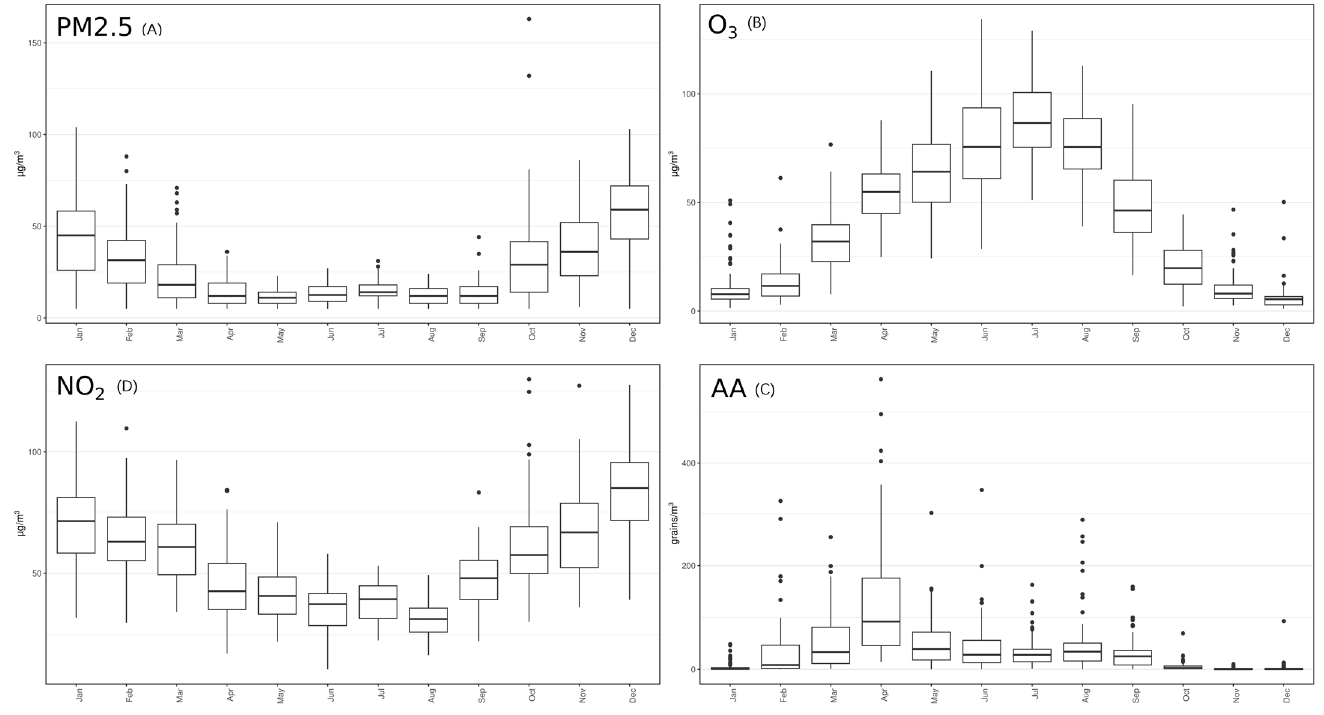
Figure 3. Mean concentration of each pollutant analyzed by month during the 3-years period under analysis. AA: aeroallergens